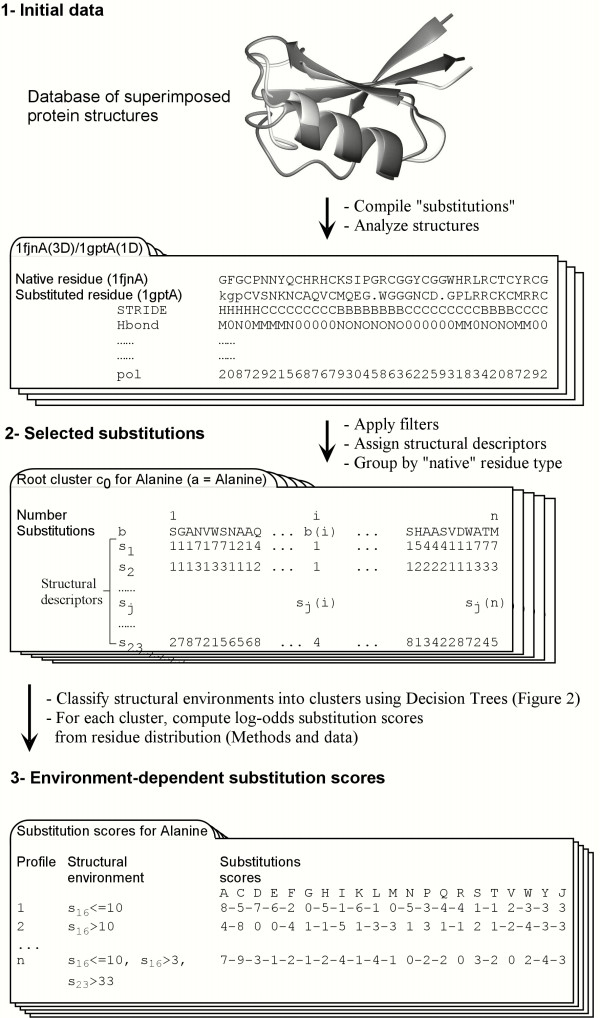
Flow-chart of the EvDTree method. 1- Initial data are pairs of superimposed protein structures. For each position, the "native" residue in the reference protein, the "substituted" residue in the superimposed protein and structural parameters are tabulated. 2- The data are filtered and grouped according to the "native" residue type, resulting in root clusters for classifications. 3- For each residue type, a hierarchical classification is achieved using a decision tree algorithm. Substitution scores are computed for all resulting clusters from residue distribution in the cluster.